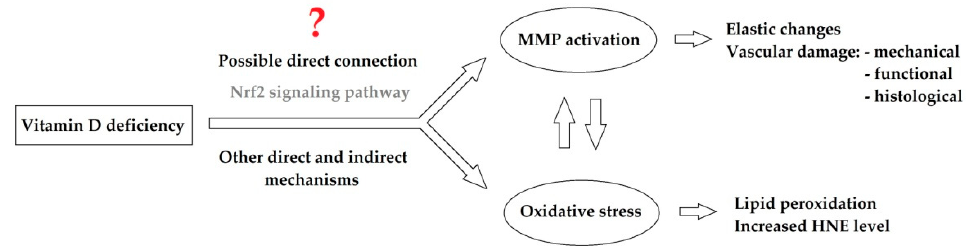
Figure 8. Hypothesized molecular background of the identified mechanical, functional, and histological small vessel alterations in a vitamin-D-deficient animal model. Abbreviations: Nrf2 = Nuclear factor erythroid 2-related factor 2; MMP = Matrix metalloproteinase; HNE = 4-hydroxy-2-nonenal.